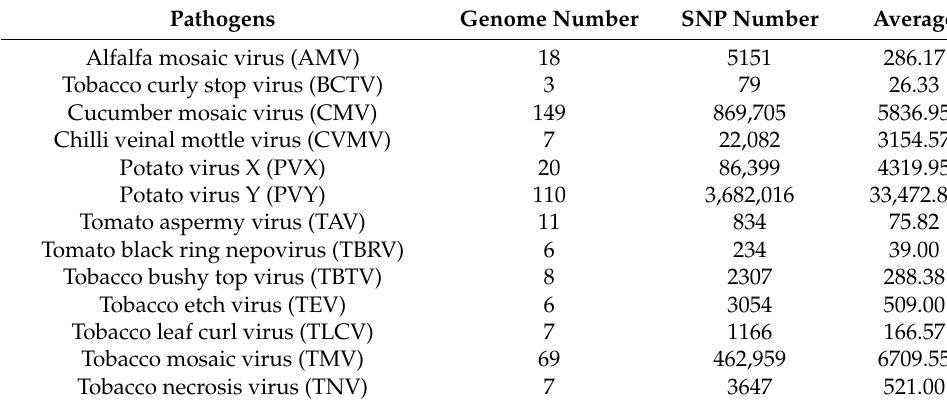
Table 4. SNPs in 19 Nicotiana